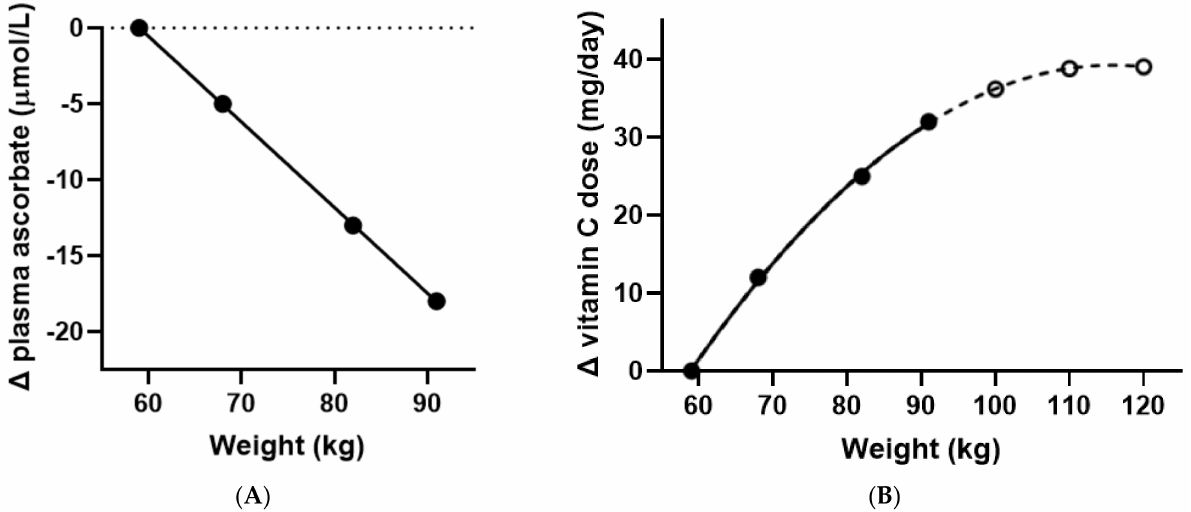
Figure 3. Decreased steady-state ascorbate concentrations with weight ( A ) and increased vitamin C requirements with weight ( B ). The dashed line represents extrapolation of the weight data